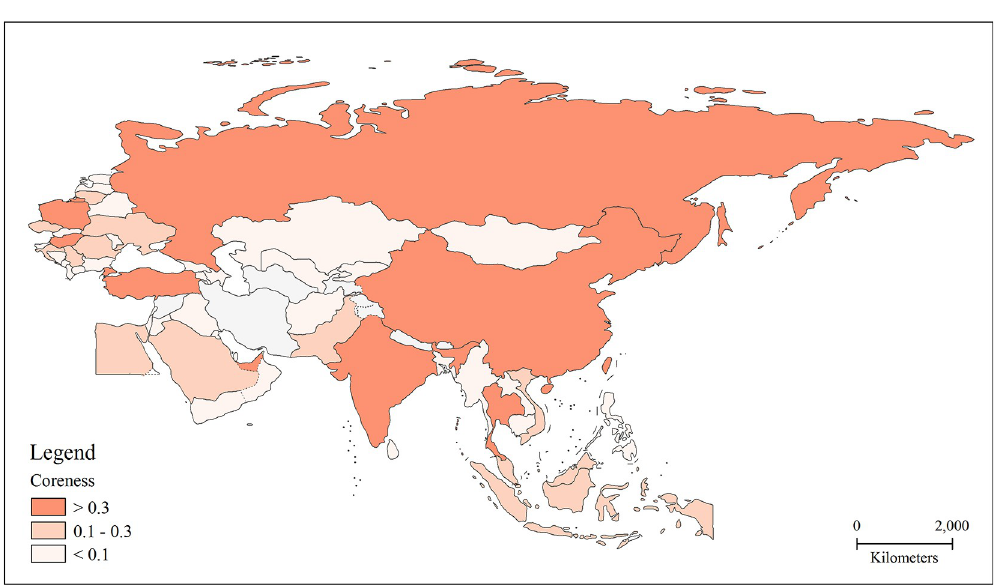
Fig 4. Core-periphery structure of the BRI trade network. Note: The basemap used to construct the map was obtained from the following source: China Map Publishing House Co., LTD. They have been republished under a CC BY license, with permission from the China Map Publishing House Co., original copyright